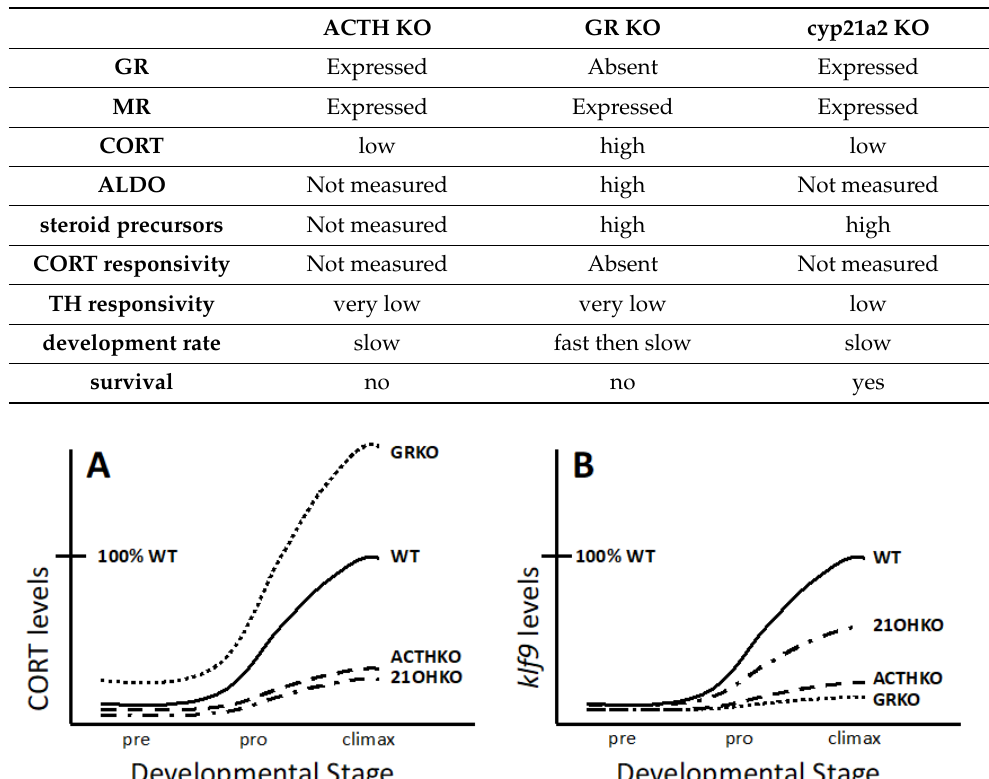
Table 2. Effects of corticosteroid mutants on hormone signaling.